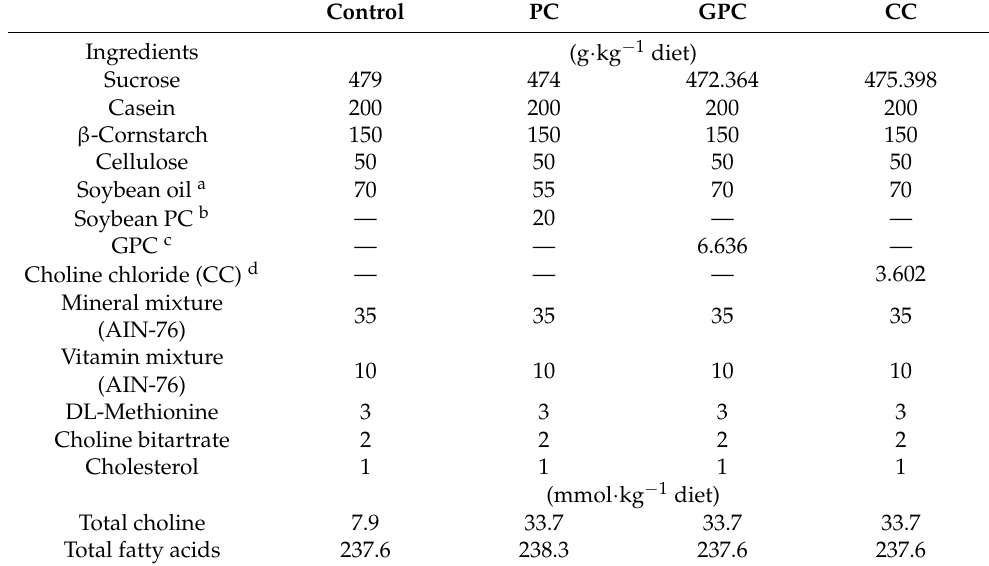
Table 3. Composition of experimental